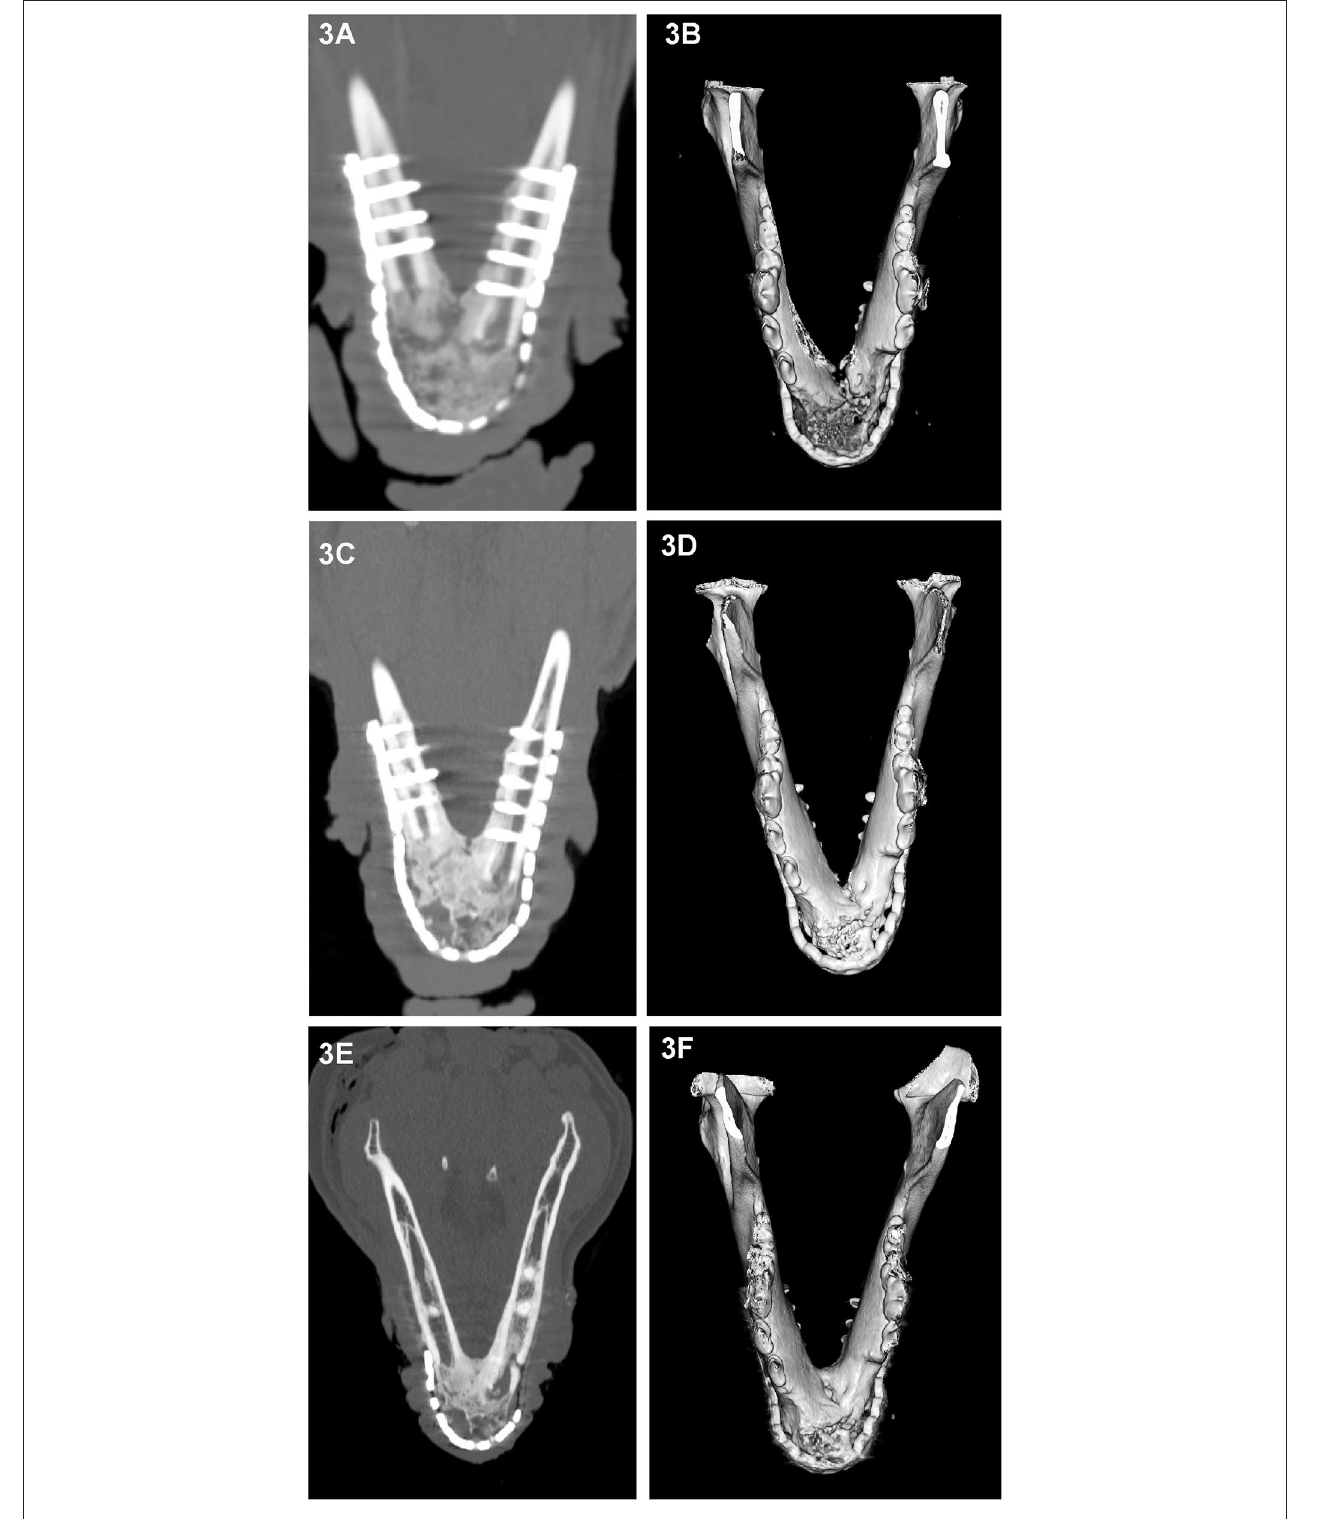
FIGURE 3 | Dorsal-plane reconstructed and 3D volume rendering of CT images of the mandibles of dog at 1 month (A,B) , 3 months (C,D) and 6 months (E,F) after rostral mandibular reconstructive surgery. The right side of the dog is displayed at the left side of each image. The radiolucent gap between the implant material and native mandible that is clearly identifiable on the 1 month dorsal-plane view (A) becomes progressively less distinct (C) over time and is barely discernible at 6 months (E) . Although at 6 months, the regenerated bone in this dog still exhibited heterogeneity, there has been substantial remodeling change as evidenced by the reduction in expansion and cortication of the margins (A,E)